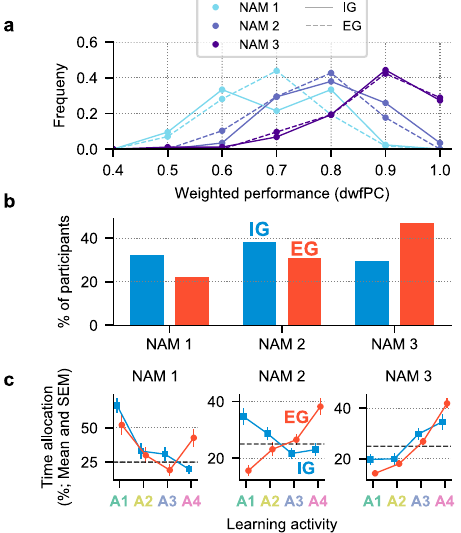
Fig. 3 Individual variability within groups. a Final performance was the same across instruction groups when accounting for the number of activities mastered (NAM). As expected, the NAM designation captured well the learning achievement of our participants. In light of ( b ), this demonstrates that many participants achieved a high performance across learning activities, even without an explicit instruction to learn. b Distributions of participants mastering 1, 2, or 3 activities in each instruction group. Whereas half of the participants in the EG group achieved high performance across learnable tasks, a sizable portion of the IG participants (almost 1/3) were motivated enough to self-challenge and learn without being asked to do so.